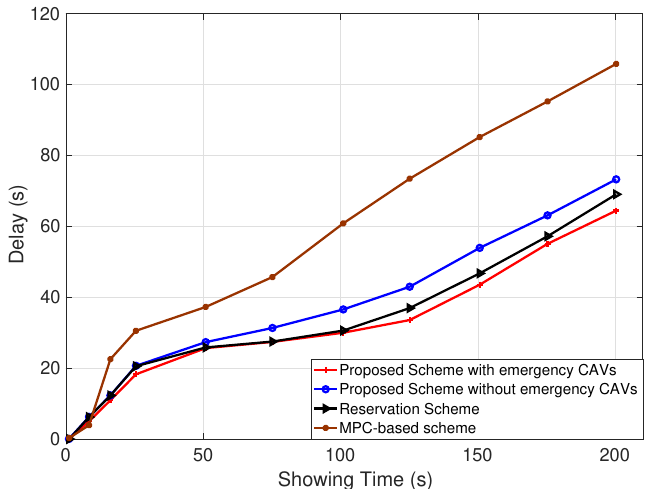
Figure 8. Delay of emergency CAVs under different